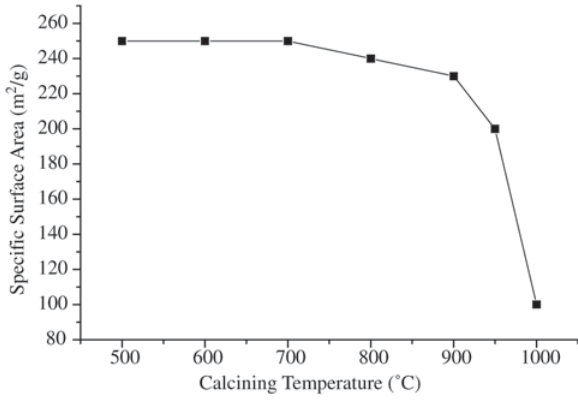
Figure 2 . Dependence of the specific surface area on calcining temperature for silica produced by process DII. Calcining time: 120